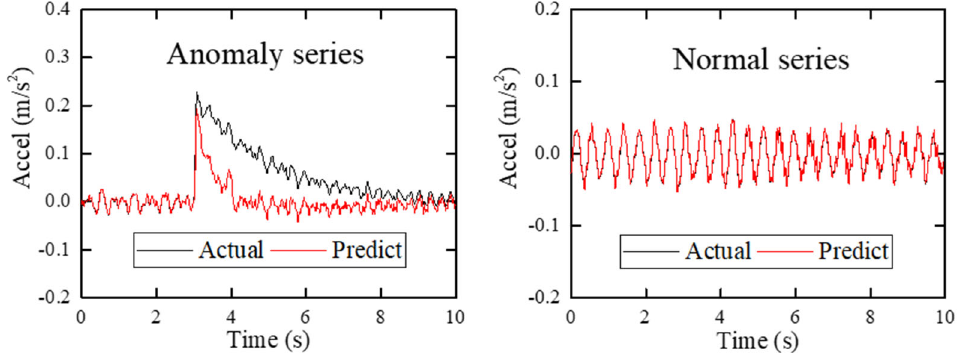
Figure 3. The prediction result of the LSTM network.